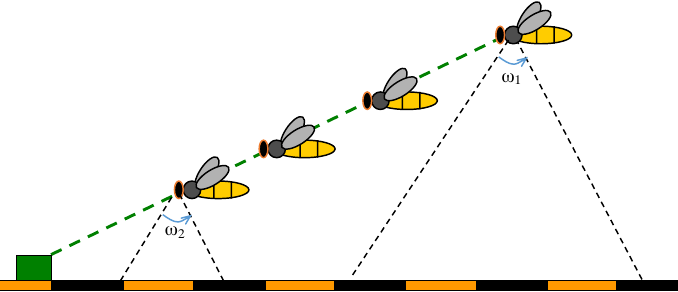
Figure 7. Honeybees make smooth landings by decreasing the flight speed progressively such that the angular velocity of the image of the ground is held constant ( ω 1 = ω 2 ). Reproduced with permission from